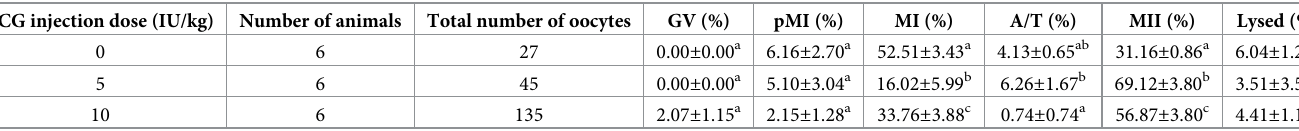
* Different superscript letters (a, b or ab) in the same column indicate statistical significance between different variables (P < 0.05). The hCG injection dose refers to the unit of subcutaneous injection of hCG in guinea pigs. The injection volume was in ml. hCG, human chorionic gonadotropin. GV: germinal vesicle; pMI: pro-metaphase I; MI: metaphase I; AI: anaphase I; TI: telophase I; MII: metaphase II.